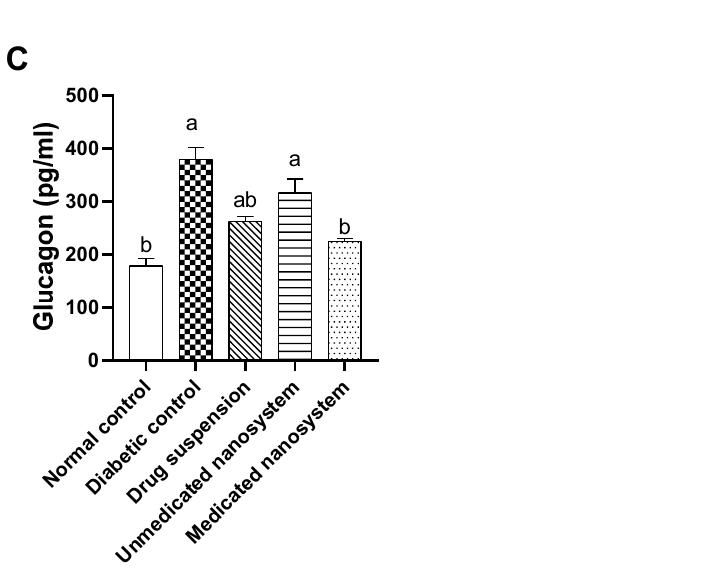
Figure 7. Effect of β -sitosterol glucoside on MDA ( A ), catalase ( B ), and glucagon levels ( C ) in STZ- induced diabetic rats. Each value denotes mean ± SEM ( n = 6). Statistical analysis was carried out by one-way ANOVA followed by Tukey’s post-hoc test. a significantly different from normal control. b significantly different from diabetic control at p < 0.05.